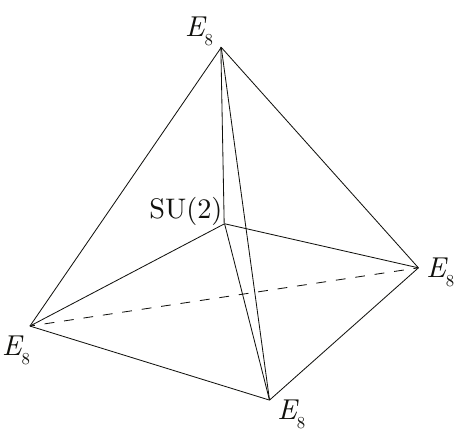
Figure 2 . The blow up of the intersection point of four divisors with E 8 .